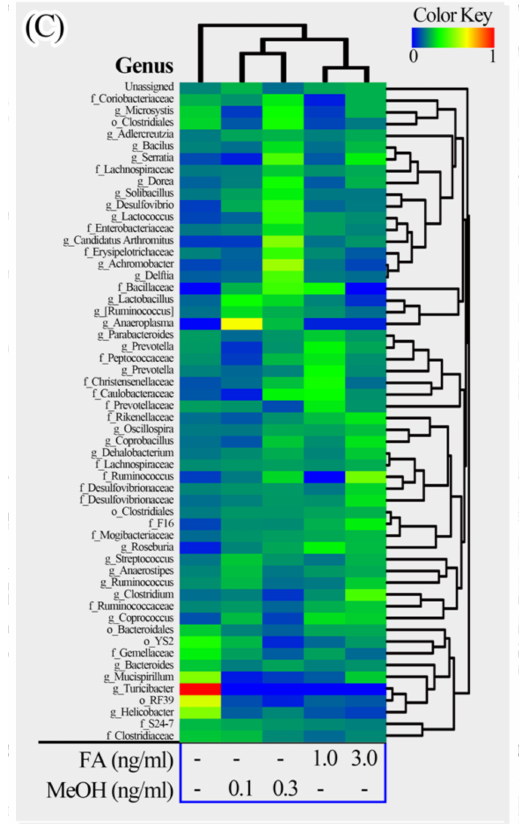
Figure 5. Heatmap illustrations of gut bacterial taxa changes at phylum, family and genus levels. The heatmaps were constructed using the software HemI [39]. ( A ) Phylum; ( B ) Family; ( C )